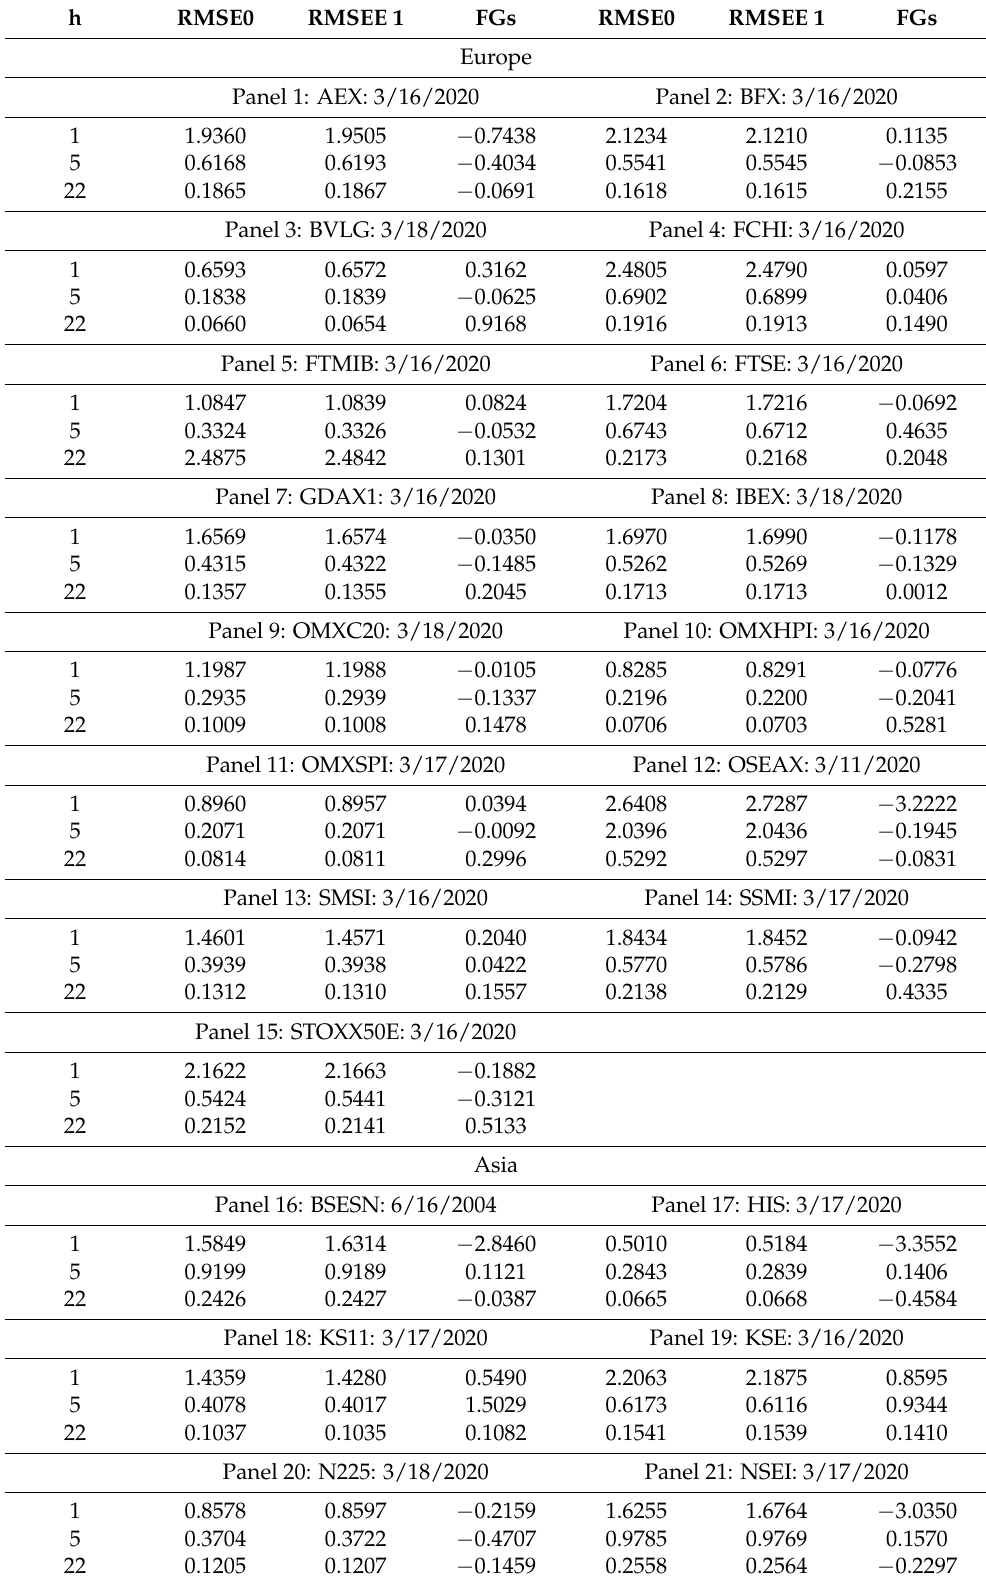
Table A2. Out-of-sample forecasting gains for the COVID-19